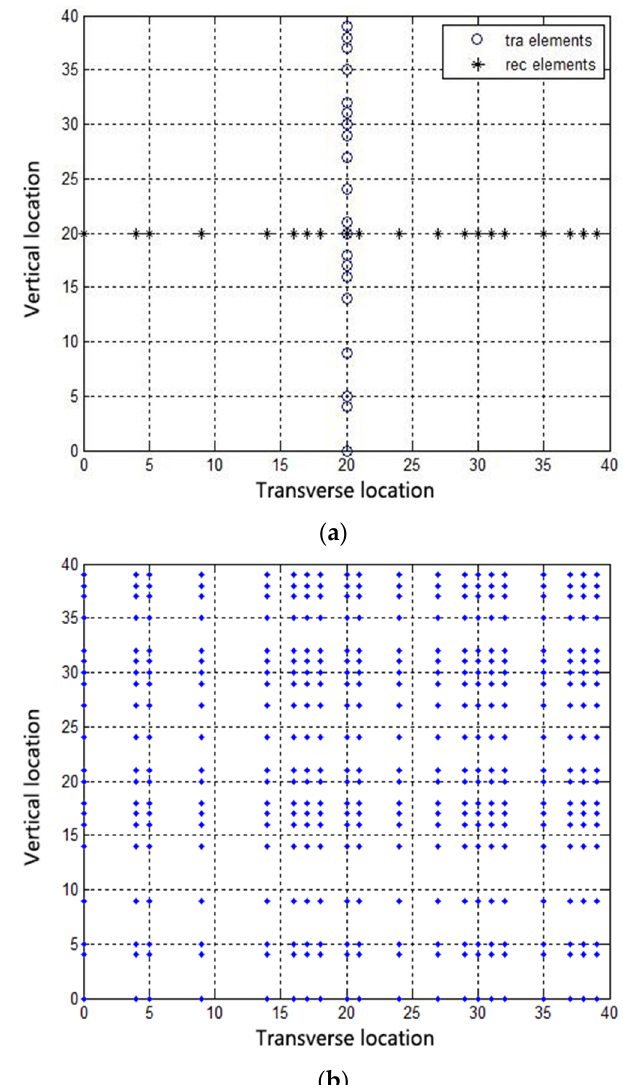
Figure 5. Thinned array from the Mills Cross array and the corresponding virtual array. ( a ) ADS thinned array form the Mills Cross array; ( b ) Virtual Array formed from subfigure ( a ).